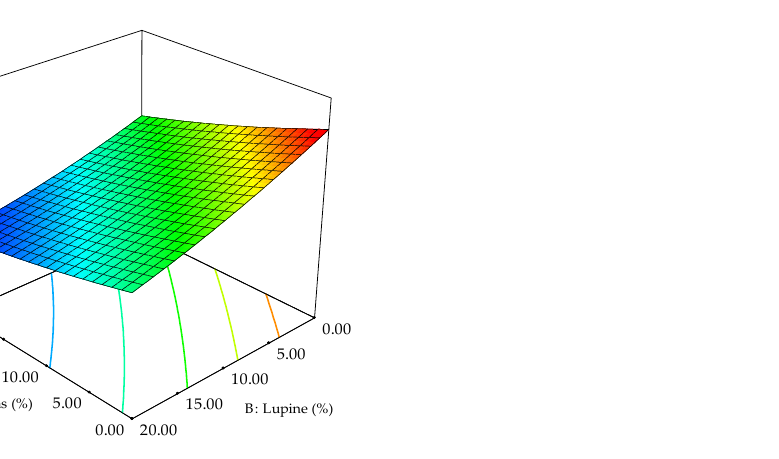
Figure 1. Response surface plot of falling number (FN) as a function of chickpea germinated flour (CGF) and lupin germinated flour (LGF) addition. The rheological behavior of dough during mixing depends on the structure and interactions between dough matrix components, the incorporation of CGF and LGF leading to lower water absorption and kneading tolerance of dough as the addition level increased (Figure 2). Since the models used are first-order, the fitted response surfaces are plane. The CGF and LGF factors exerted significant ( p < 0.05) influence on these parameters, while the interaction between factors was not significant ( p > 0.05) (Table 2).